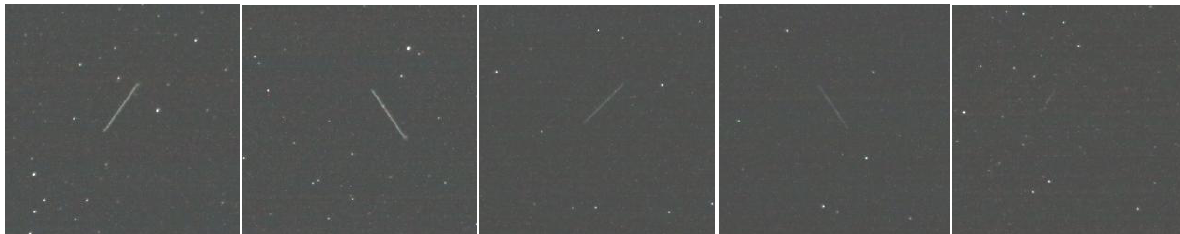
Figure 14. Aspect of satellites in the image space. From left to right: 733, 738, PRN10, PRN8, Molniya 3-41. Average satellites’ brightness: 55, 65, 30, 22, 15 DNU. Average background brightness: 5 DNU.